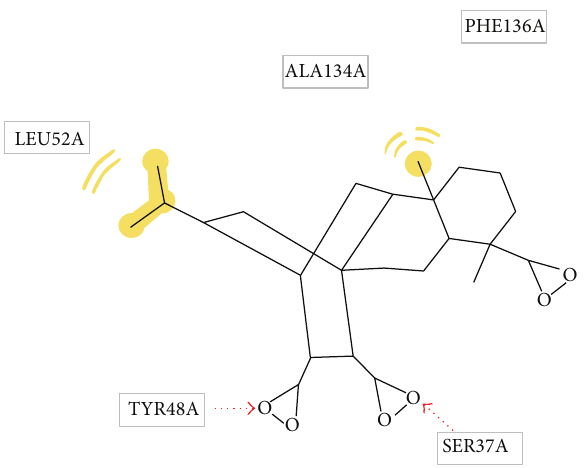
Figure 4: Two-dimensional spatial arrangement of the pharma- cophore model showing hydrogen bonds between “SER37A and O”, “TYR48A and O”. Hydrogen bonds were represented by red- coloured dotted arrows and yellow colour represents hydrophobic (HY) interaction with ALA134A and PHE136A residues.